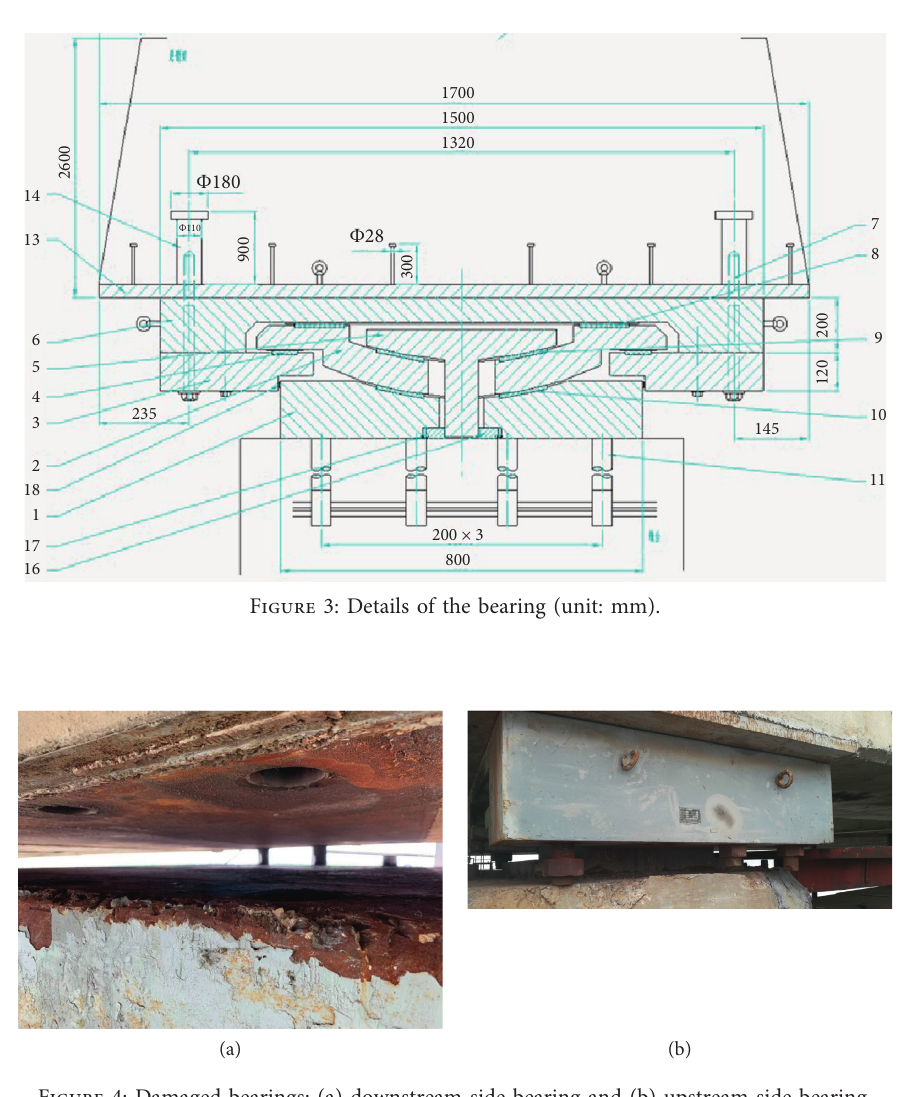
Figure 4: Damaged bearings: (a) downstream side bearing and (b) upstream side bearing.